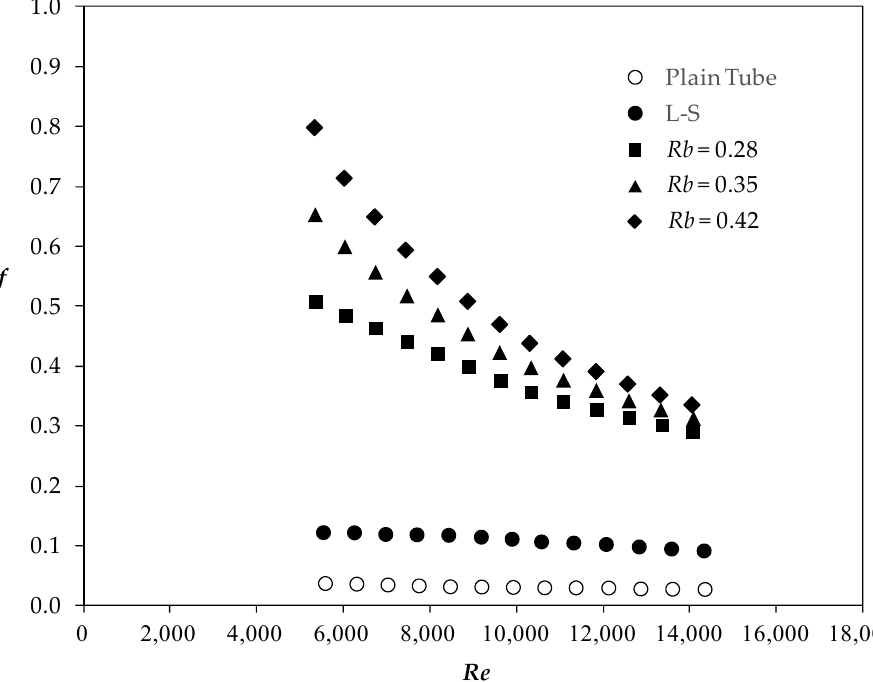
Figure 7. Effect of blockage ratio ( R b ) on the friction factor behavior ( f ) with Reynolds number ( Re ).